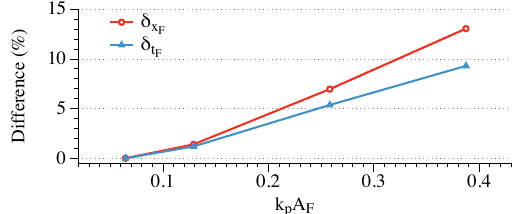
Figure 18. The relative spatial differences in focusing location δ x F and temporal differences in focusing time δ t F in relation to wave steepness in the simulation with the wave